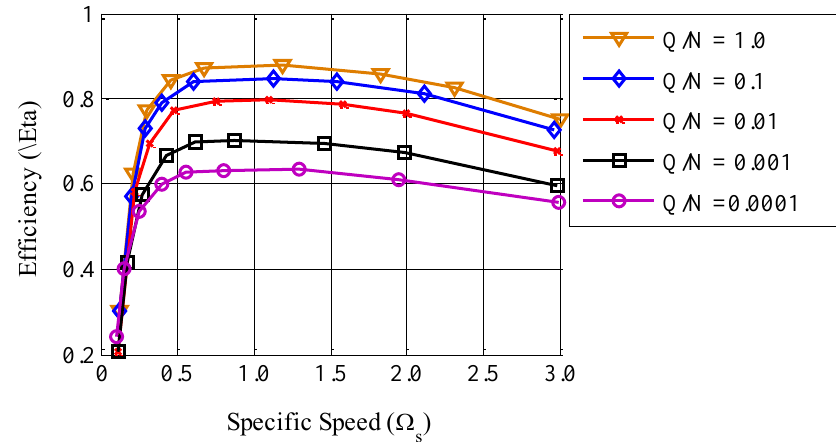
Figure 10. Velocity contours and velocity vector on a plane at 50% span location.